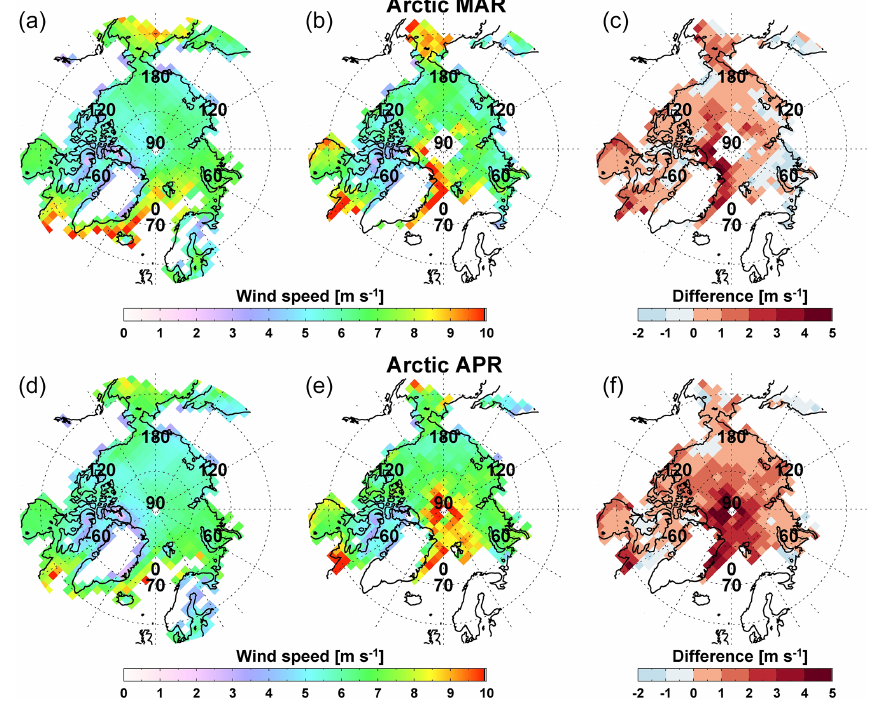
Figure 10. Monthly wind speed at 10m for the mean field (a, d) , the enhanced BrO case (b, e) , and surface wind speed anomalies (difference of wind speed between the enhanced BrO case and the mean field) (c, f) over the Arctic in March (a–c) and April (d–f)